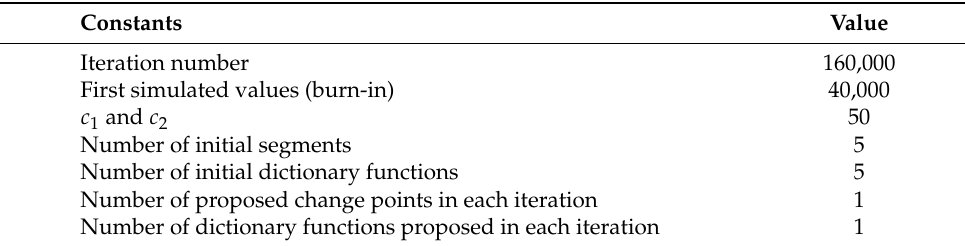
Table 2. Constants used for model execution.